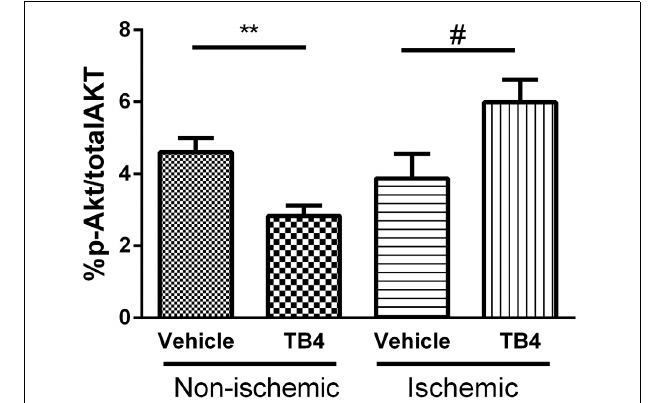
FIGURE 7 | TB4 treatment reduces infarct sizes without affecting area-at-risk in the acute ischemia-reperfusion model in the rat. Shown are representative hearts from a treatment and a control animal, sectioned from apex to base (clockwise). White areas represent infarcted tissue; red areas are viable, and blue tissue was not at risk of infarct. The heart from the TB4-treated animal (right panel) shows reduced infarct sizes at multiple levels in comparison to the heart from the vehicle-treated animal.